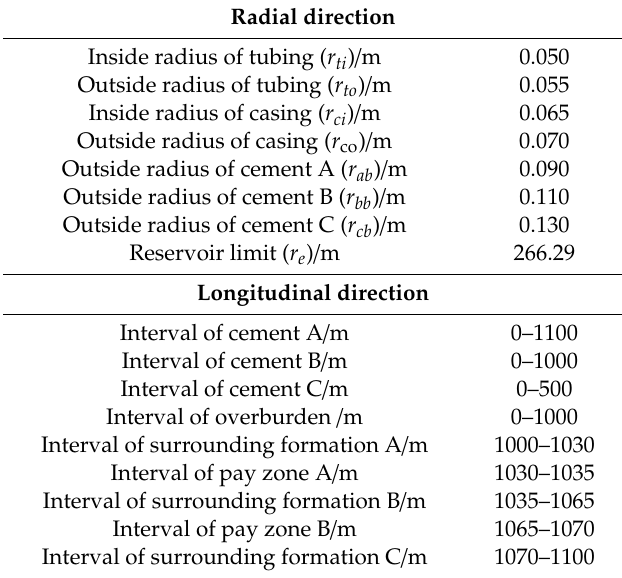
Table 4. Downhole geometry parameters.